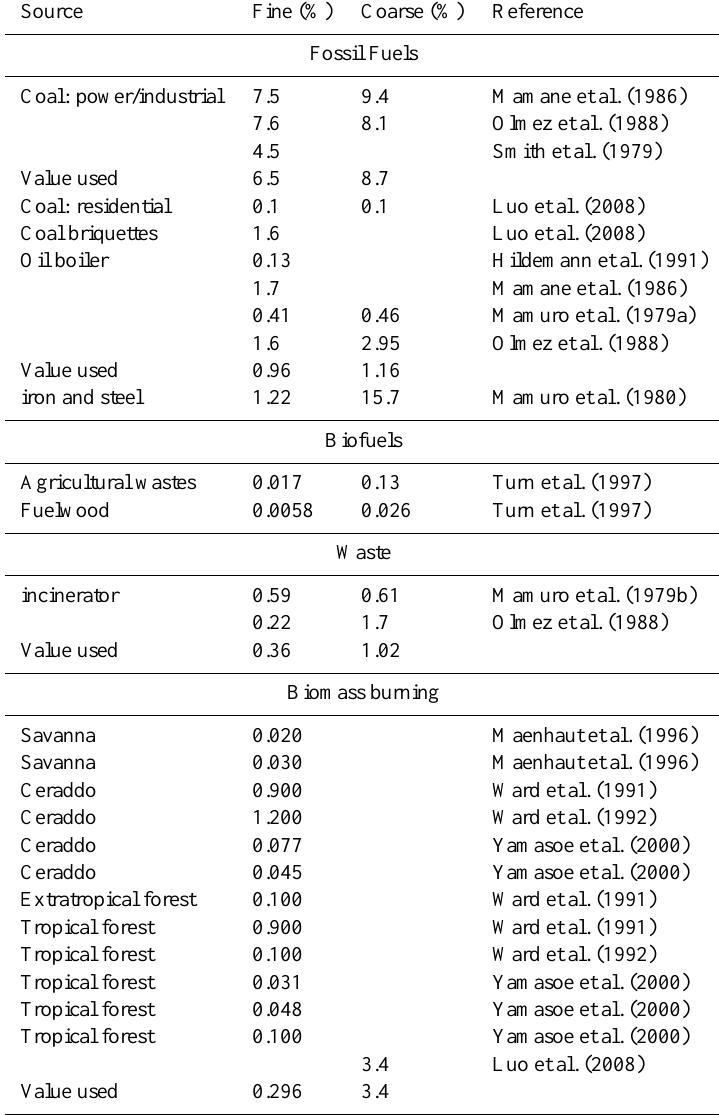
Table 2. Iron Fractions of Combustion Emissions in